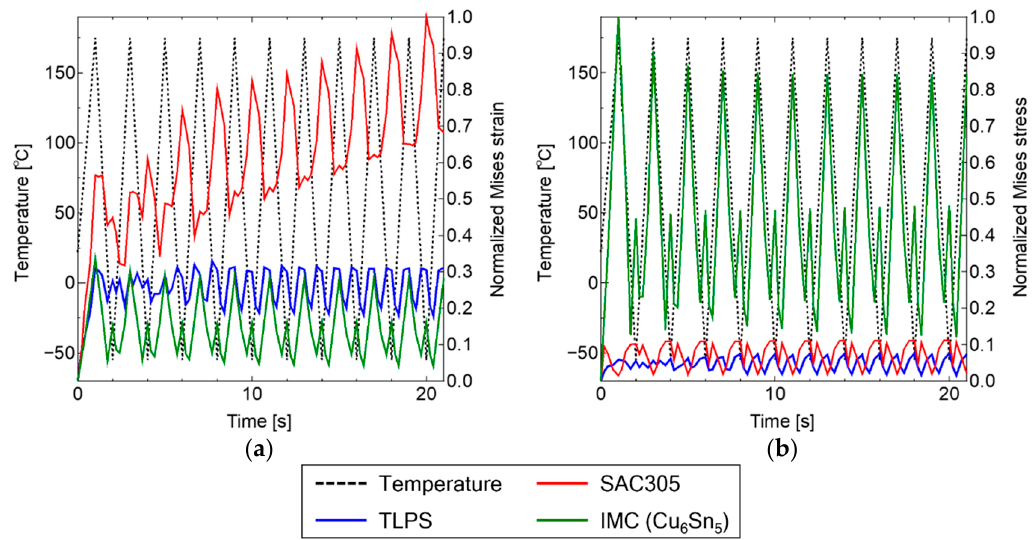
Figure 10. Evolution of calculated ( a ) normalized Mises strain and ( b ) Mises stress in TLPS, SAC305, and IMC (Cu 6 Sn 5 ) joints during the ten thermal